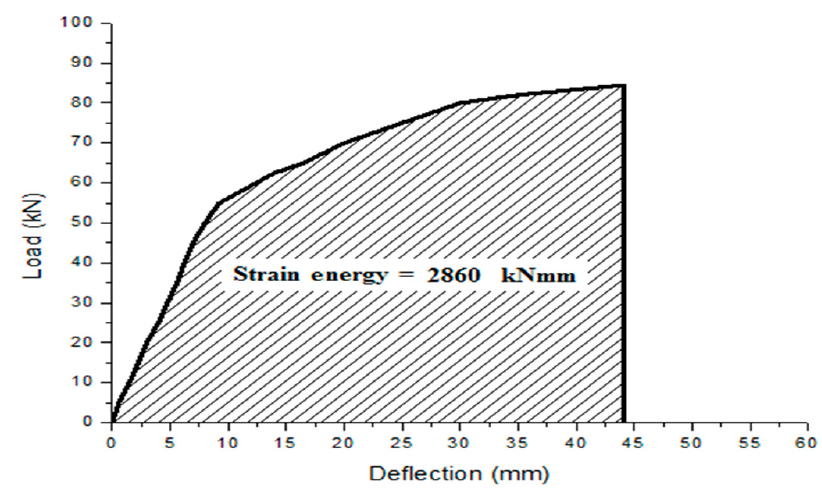
Figure 15. Strain energy for rectangular profiled composite slab—Trial I.